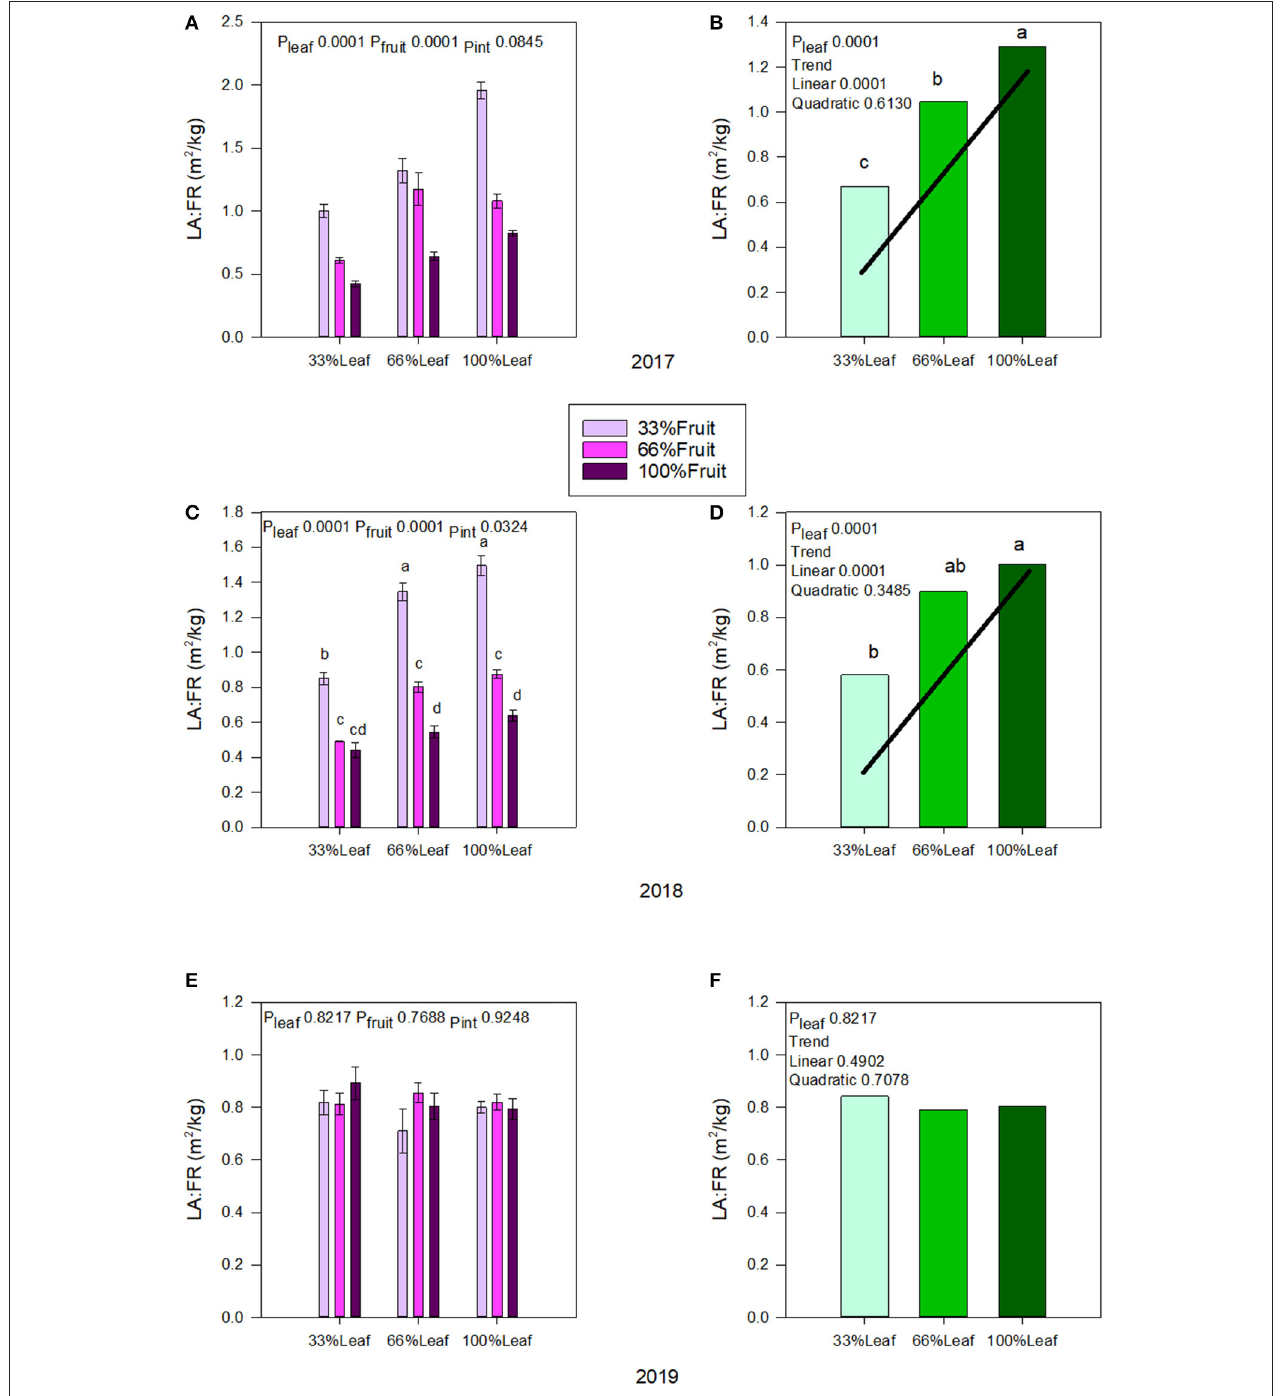
FIGURE 3 | Effect of defoliation and fruit removal on leaf area to fruit mass (LA:FR) on Cabernet Sauvignon grapevine in 2017 (A,B) ; 2018 (C,D) ; 2019 (E,F) . The interactive effects and simple means with standard error of the mean in each year are presented in (A,C,E) . The main effect of defoliation with significant trend line are presented in (B,D,F) . Columns with different letters in main effect panels are significantly different at P < 0.05 according to Tukey’s HSD.